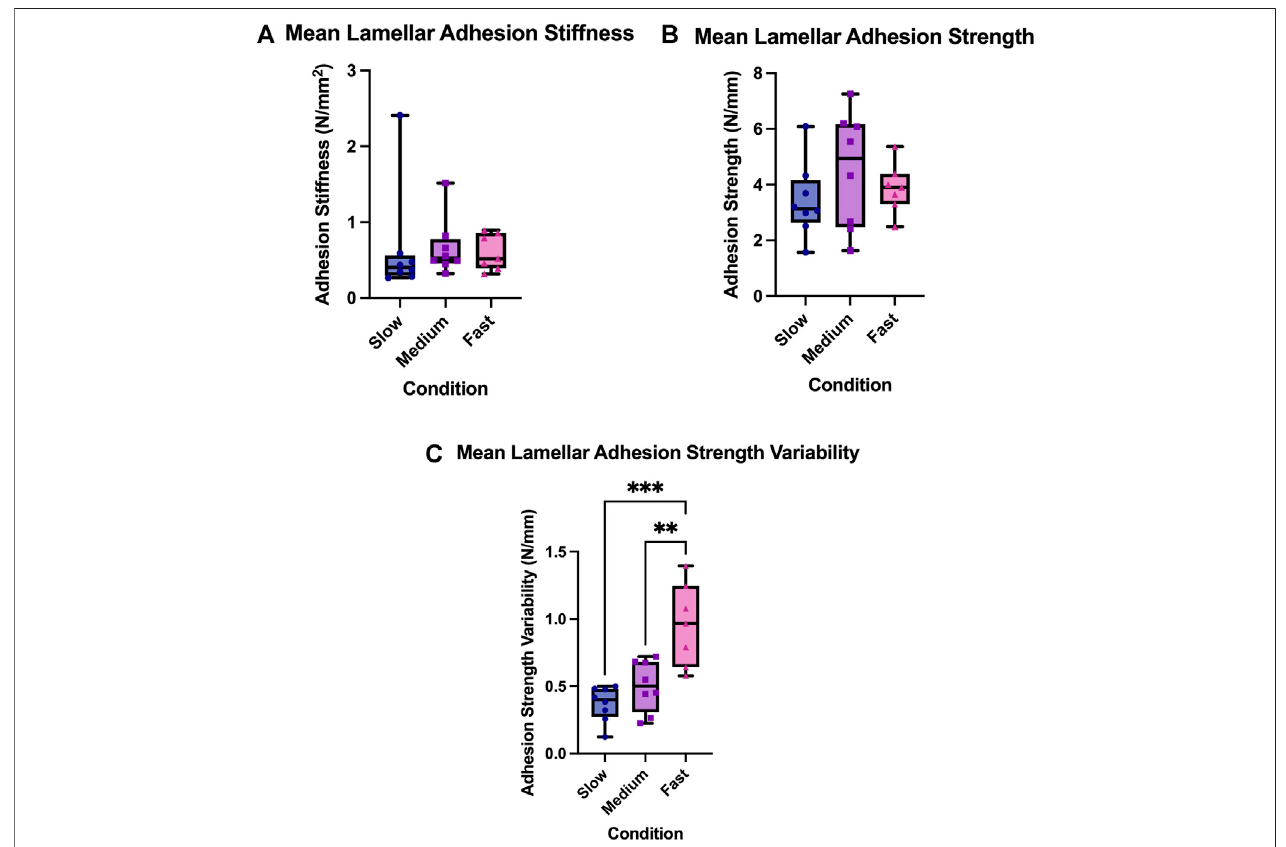
FIGURE3|(A) Lamellaradhesionvariability, (B) Lamellaradhesionstrength,and (C) Lamellaradhesionstrengthvariabilityforthethreeexperimentalratecondition; the slow condition (0.05 mm/s), the medium condition (0.5 mm/s), and the fast condition (5.0 mm/s). The box extends from the 25% percentile to the 75% percentile value,thelineinsidethebox represents themedian, and theerrorbars indicate therangeforeach experimentalgroup. Asterisksindicatesigni fi cantdifferencesbetween groups ( p < 0.05).